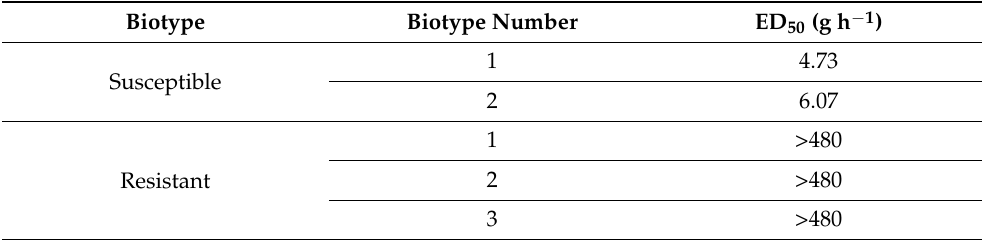
Table 1. The effective doses (ED 50 ) of tribenuron-methyl causing 50% loss in plant biomass measured for Centaurea cyanus biotypes susceptible and resistant to the herbicide